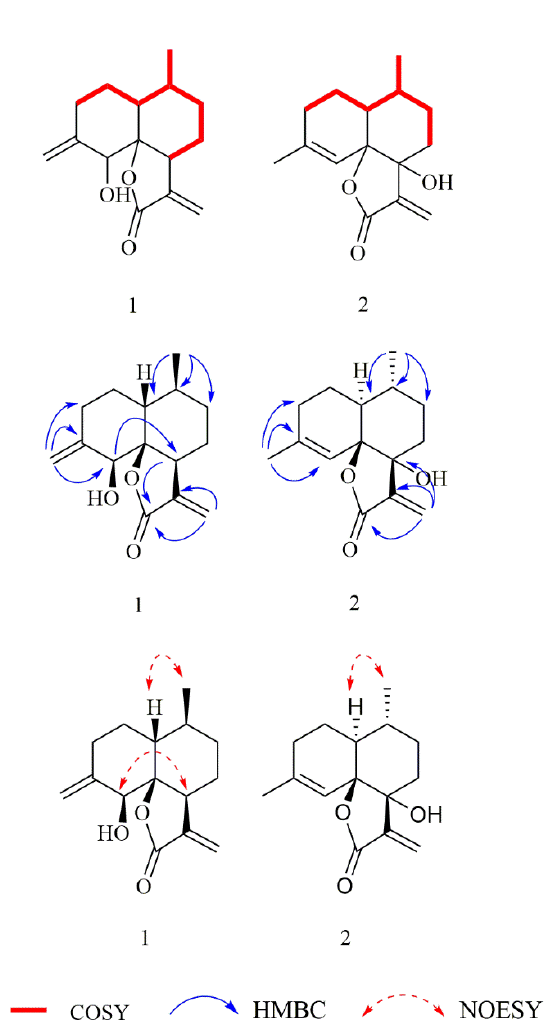
Figure 2. 1 H- 1 H COSY, HMBC, and 1 H- 1 H NOESY correlations for 1 – 2 . The NOESY correlations (Figure 2) of H-1/H 3 -14 revealed that H-1 and H 3 -14 were cofacial and randomly assigned as β -oriented, and the correlation of H-5/H-7 showed they were on the opposite sides and assigned as α -oriented, while the relative configuration